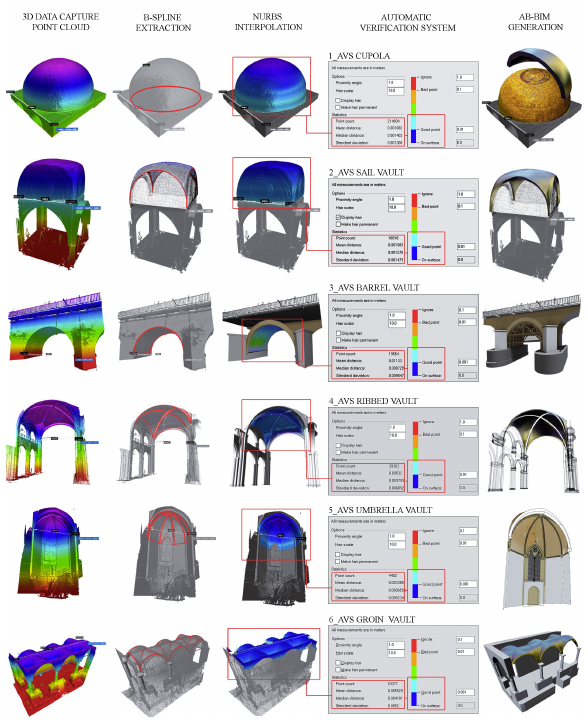
Figure 16. Thanks to GOG 10 and the add-in for Autodesk Revit users to get a GOA of 1 mm for complex